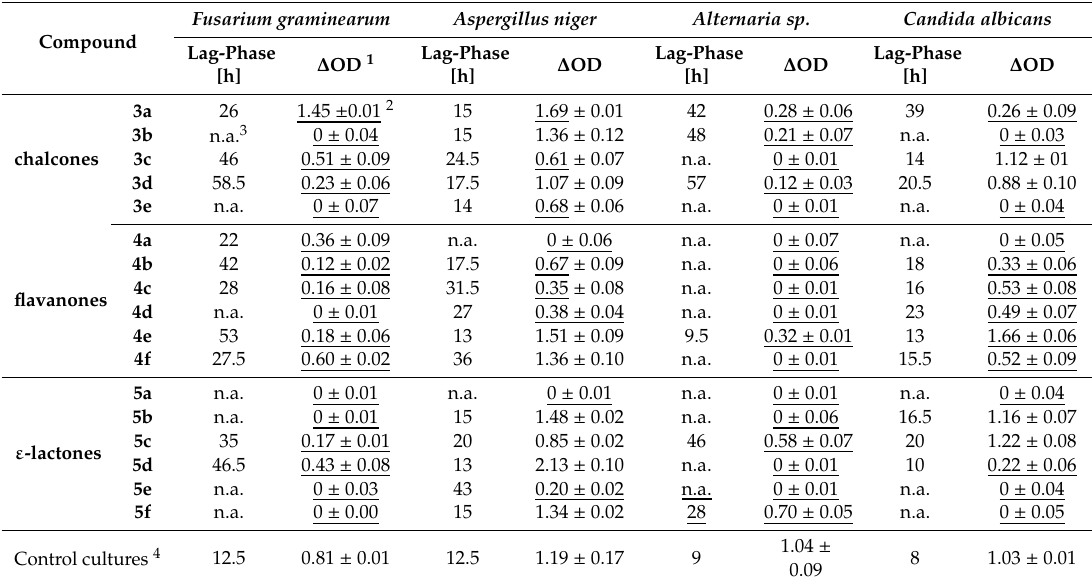
Table 2. E ff ect of chalcones 3a – e , flavanones 4a – f , and ε -lactones 5a – f on the growth of selected filamentous fungi and